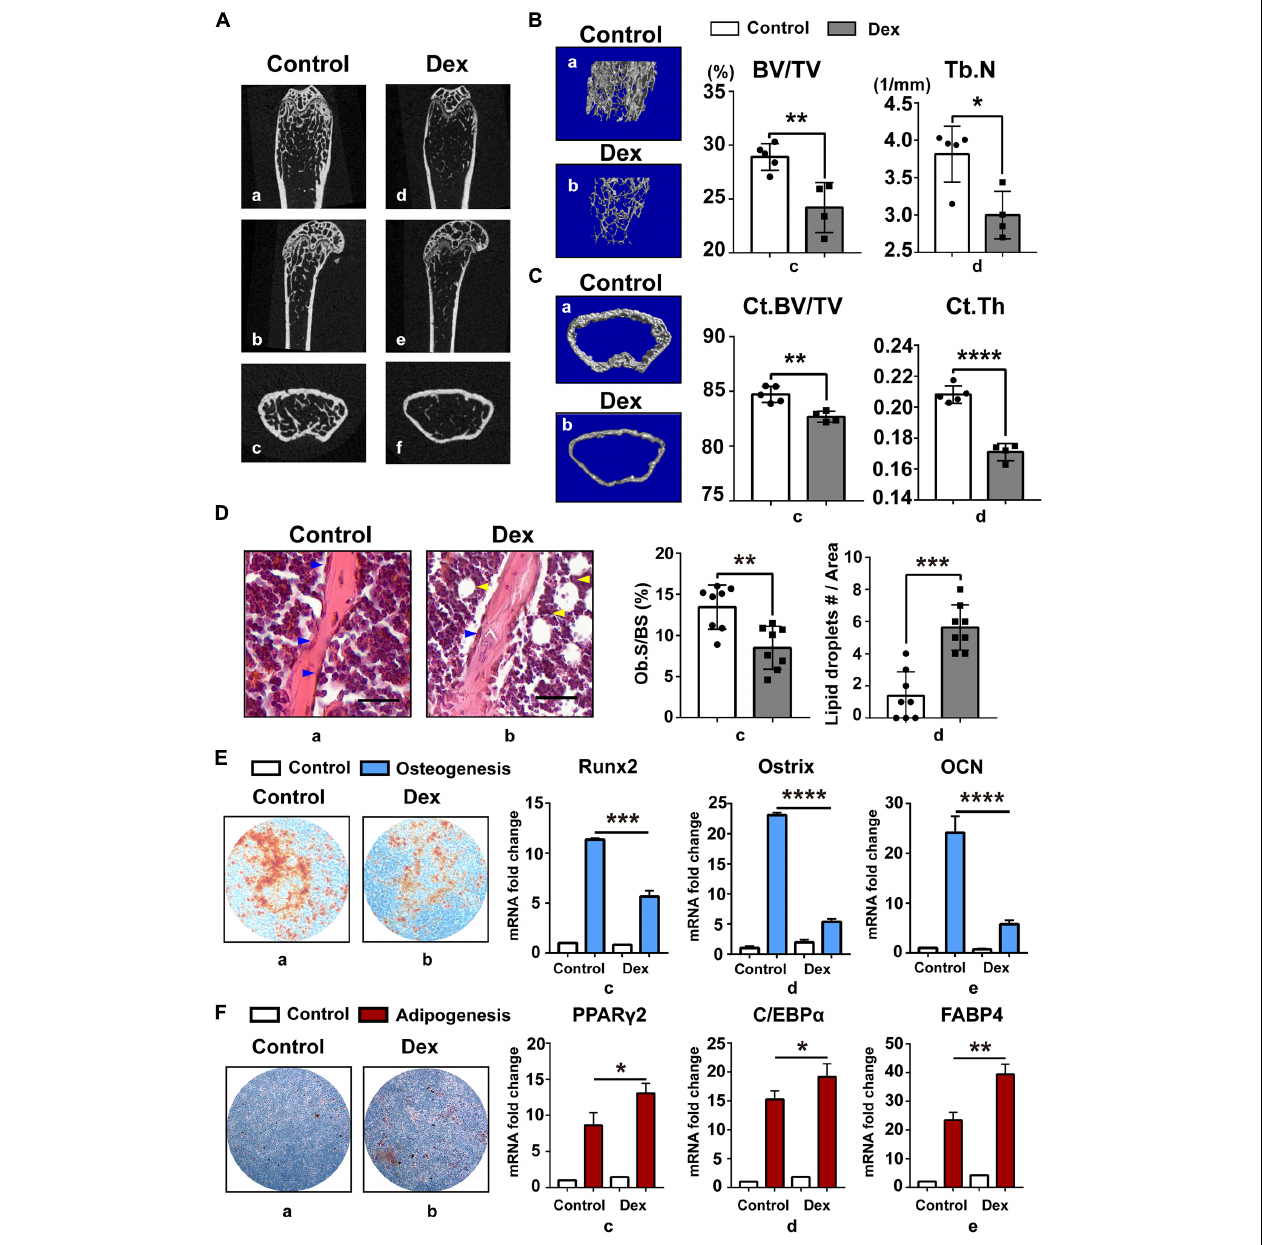
FIGURE 1 | Enhanced adipogenesis and weakened osteogenesis were found in BM-MSCs of GIOP mouse model. (A) Represented images of the coronal (a,d) , sagittal (b,e) , and transverse (c,f) of distal femur in 8–12-week-old mice, as measured by micro-CT 2D restoration ( n = 5, control group; and n = 4, Dex injection group) ; (B) represented images of three-dimensional (3D) cancellous restoration (a,b) , bone volume/tissue volume ratios (%) (BV/TV) (c) , trabecular number (Tb.N) (d) of the distal femur cancellous bone in 8–12 week-old mice, as measured by micro-CT scan ( n = 5, control group; and n = 4, Dex injection group). (C) Represented images of three-dimensional (3D) cortical restoration (a,b) , cortical bone volume/tissue volume ratios (%) (Ct.BV/TV) (c) , cortical thickness (Ct.Th) (d) of the distal femur cortical bone in 8–12 week-old mice, as measured by micro-CT scan ( n = 5, control group; and n = 4, Dex injection group). (D) HE staining of distal femur on paraffin-embedded bone sections in control group (a) and Dex injection group (b) mice (scale bar, 100 mm; blue arrow heads point to osteoblasts, yellow arrow heads point to lipid droplets); osteoblast surface/bone surface ratios (Ob.S/BS) (c) and the number of lipid droplets (lipid droplets #/Area) (d) are shown on the right. (E) Arizarin Red staining of BM-MSCs in control (a) and Dex injection group (b) after 21-day osteogenic induction; Runx2 (c) , Ostrix (d) , OCN (e) mRNA levels in day 0 and day 7 after osteogenesis, as measured by qPCR. (F) Oil Red O staining of BM-MSCs in control (a) and Dex injection group (b) after 14-day adipogenic induction; PPAR γ 2 (c) , C/EBP α (d) , FABP4 (e) mRNA levels in day 0 and day 7 after adipogenesis, as measured by qPCR. Data are shown as the mean ± SEM. * p < 0.05, ** p < 0.01, *** p < 0.005, **** p < 0.001. All the data were obtained from at least three independent experiments.